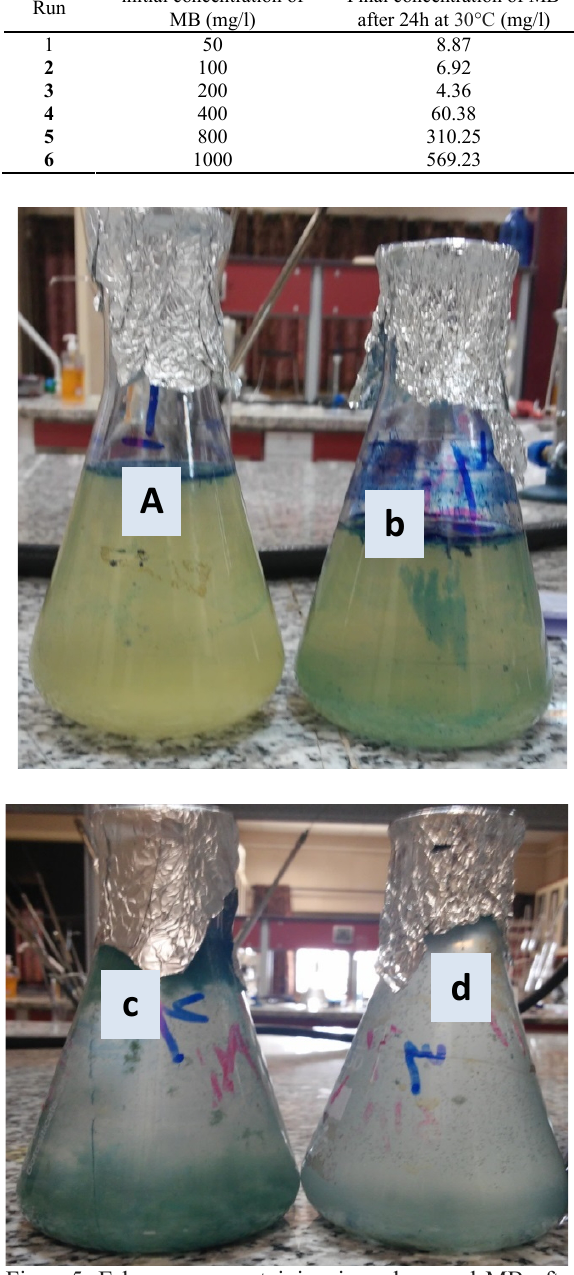
Figure5. Erlenmeyer containing inoculum and MB after removal, initial concentrations of MB a) 50, b) 100, c)